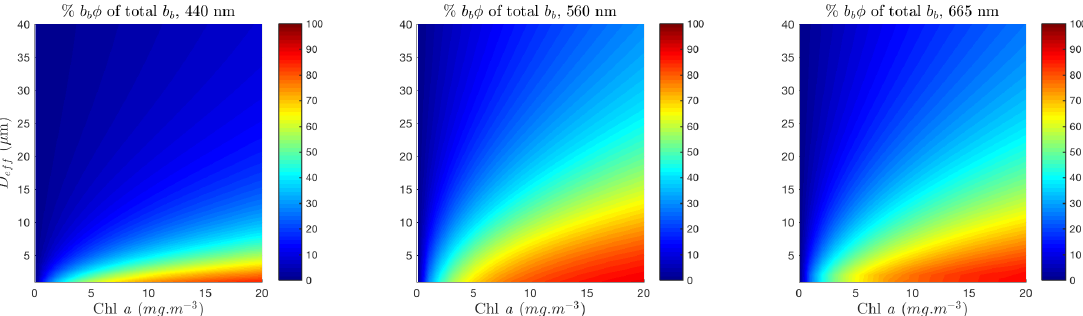
Figure 13. Percentage contribution of phytoplankton to total backscatter (including water, and with nominal b bnap (550) = 0.005), shown for D ef f 1 to 40 µ m and Chl a from 0.1 to 20 mg/m 3 , at 440, 560 and 665